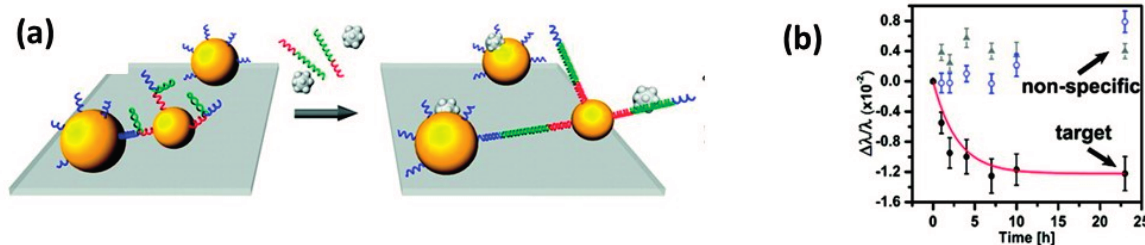
Figure 3. The detection of DNA is demonstrated in complex serum by tethering two gold nanoparticles together through a single strand of DNA with a hairpin loop. In the presence of target DNA, hybridization occurs at the hairpin loop increasing the space between the dimers resulting in a spectral blue shift as a result of decreased plasmonic coupling with great specificity. Reproduced with permission from